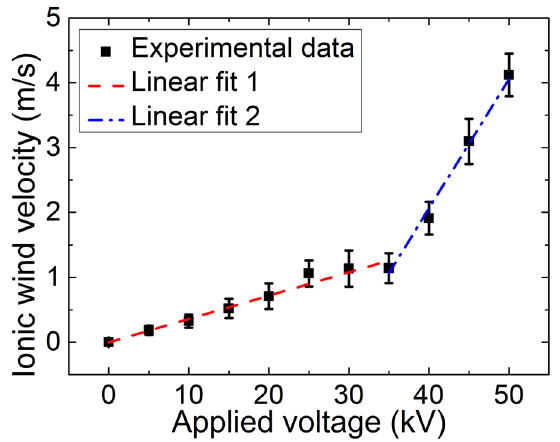
Figure 3. The maximum ionic wind velocity as a function of the applied voltage. Squared points are the measurement results and the red dashed and blue dashed dot line are the linear